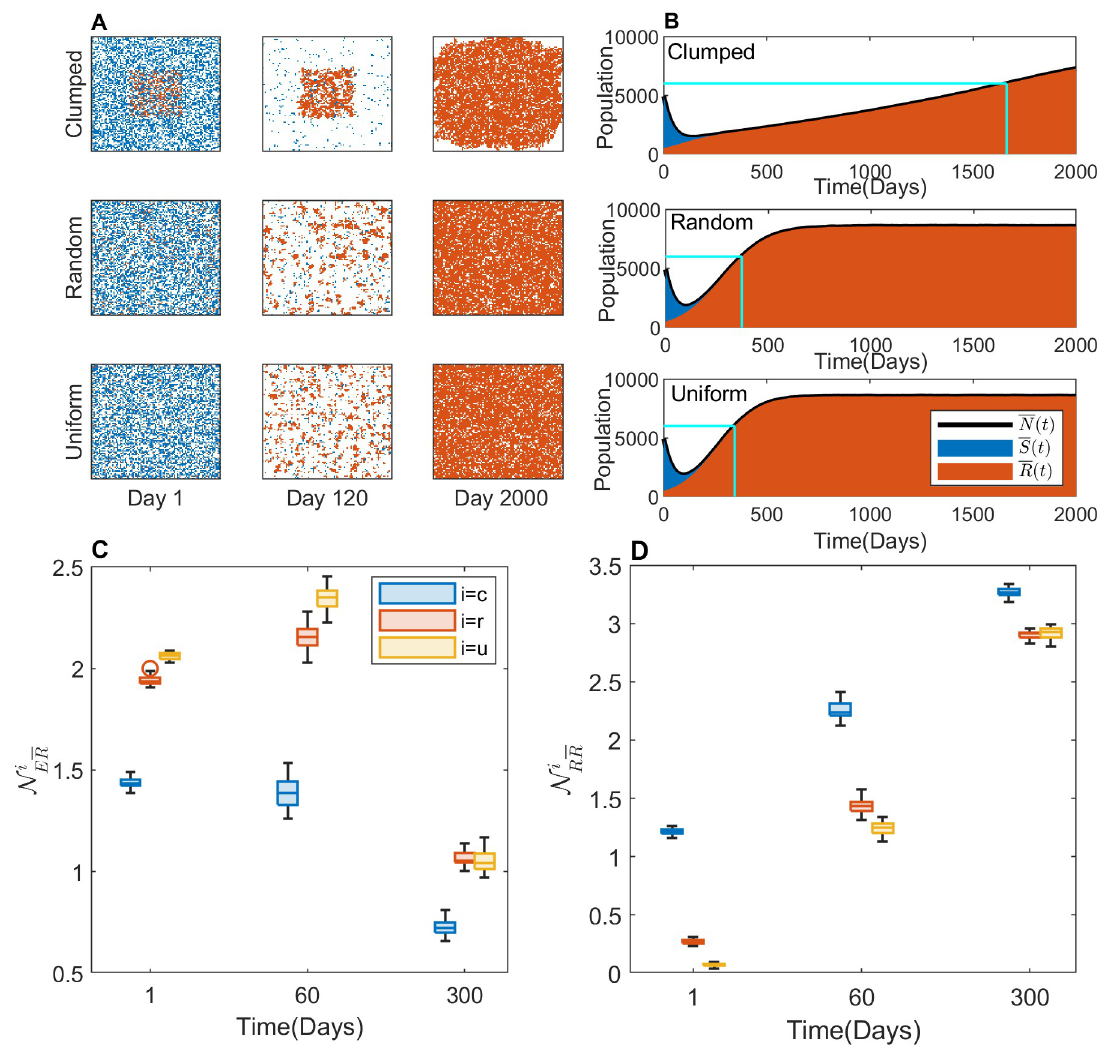
Fig 4. Effects of initial R-cell distribution on the TTP under CT-MTD. ( A ) The cell configurations on days 1, 120, and 2000 are shown. The blue, orange, and white dots are S-cells, R-cells, and empty sites, respectively. ( B ) The average temporal evolution of the average number of S-cell and R-cell populations over 30 realizations with clumped (upper panel), random (middle panel), and uniform (bottom panel) initial cell configurations (blue: S-cell, orange: R-cell). Black solid line: average total cell population ( � N ð t Þ ¼ � S ð t Þ þ � R ð t Þ ). Vertical cyan line: TTP in each case; horizontal cyan line: the 120% level of the initial tumor volume (tumor progression threshold). The average numbers of empty sites ( N i ) and R-cells ( N i ) in the VNHD of an R-cell in the 30 realizations are shown as boxplots in ( C ) and ( D ), E � R R � R respectively, for i = c , r , u . The blue, orange, and yellow boxes are for the clumped ( c ), random ( r ), and uniform ( u ) cases, respectively.